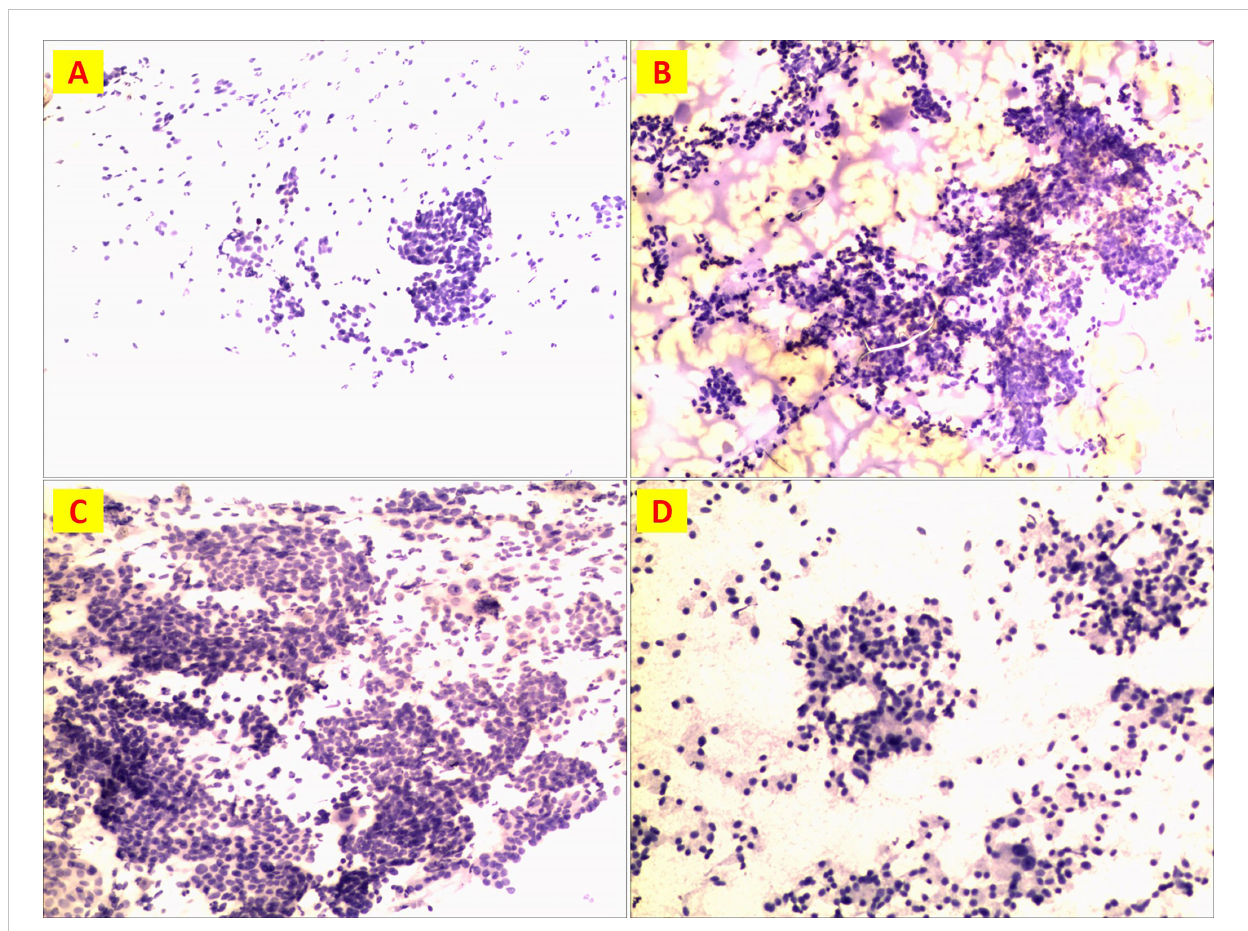
FIGURE 7 Preoperative FNA detection. (A) Patient n.18 suspicious cancer; (B) Patient n. 5 PTC; (C) Patient n. 26 PTC; (D) Patient n. 26